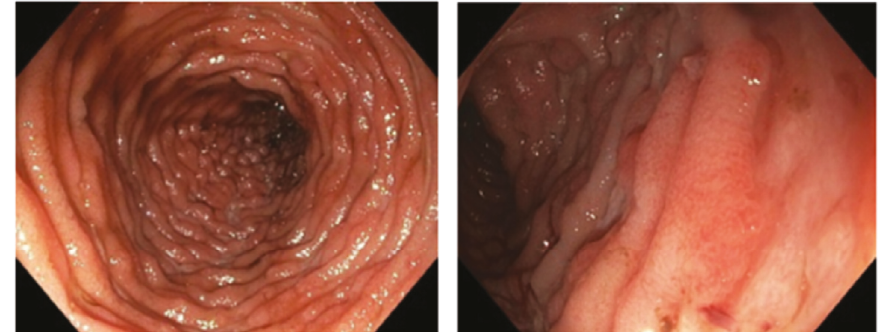
Figure 2: Colonoscopy images. Extensive involvement of the terminal ileum with circumferential ulcerations and inflammation (left). Detailed view of erosions and inflammation seen throughout the ileum (right).